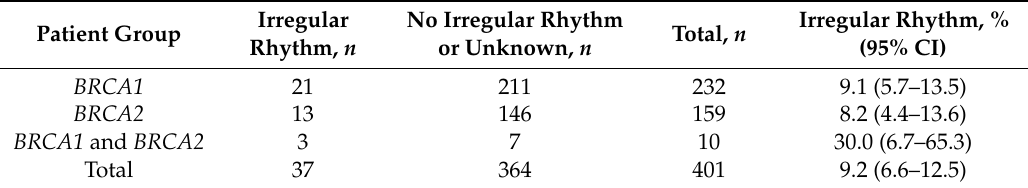
Table 4. Arrhythmias in BRCA